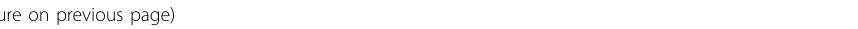
Fig. 1 NOXA is a highly expressed but short-lived protein in CRC. A , B Box plots of NOXA DNA copy numbers ( A ) and mRNA expression levels ( B ) in normal colorectal tissue and colorectal carcinoma tissues in two independent datasets from Oncomine ( n = number of biologically independent samples). The data sets were taken from TCGA 25 and Hong 26 . Points: minimum and maximum, whiskers: 10th and 90th percentiles, boxes: 25th and 75th percentiles, lines: medians; unpaired t test. C Immunohistochemical analysis of NOXA expression levels in ANT ( n = 49) and CRC tissue ( n = 53) (**** p < 0.0001). The expression level of NOXA was scored from 0 to 300 according to the staining intensity. D Comparison of proliferation ability among 5 CRC cell lines (DLD1, SW480, SW620, HT29, and HCT116). Cells were seeded into 96-well plates (2000 cells per well) in triplicate and subjected to a CCK8 assay every 24 h for a duration of 120 h. The mean ± SD of four independent experiments is shown (* p < 0.05). E Comparison of NOXA expression in the 5 CRC cell lines by WB analysis. The NOXA level in DLD1 cells on the left was 1, and Tubulin was used as the loading control. The mean ± SD of three independent experiments is shown. F Comparison of the NOXA degradation rate in the 5 CRC cell lines by WB analysis. Measurement of NOXA T 1/2 : Cells in 6-well plates were switched to fresh medium (10% FBS) containing CHX (20 μ g/mL) and incubated for the indicated time periods before being harvested for WB analysis. The results are representative of three independent experiments, and band densities were quanti fi ed using Image Lab software and plotted using Prism 8 software (mean±